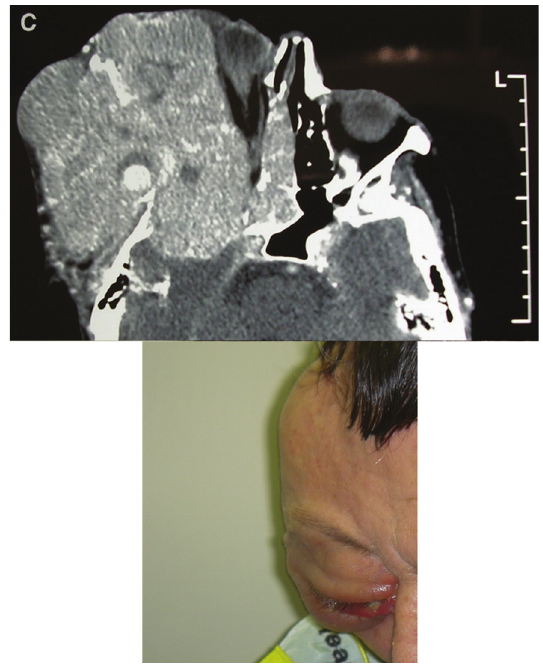
Figure 4. Massive growth of the orbital mass is shown on computed tomography (top) and clinically